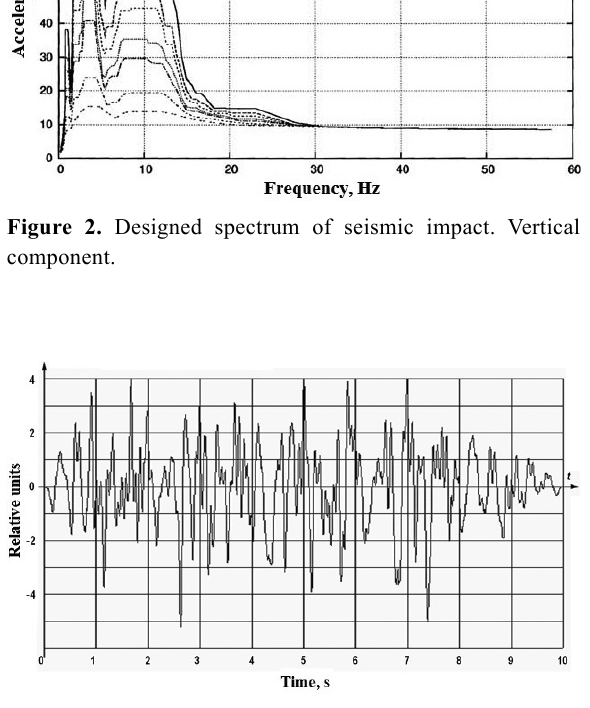
Figure 3. Synthesized accelerogram of the seismic impact. Ver- tical